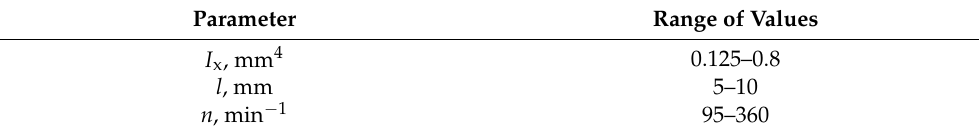
Table 3. Extended value ranges of the studied parameters.